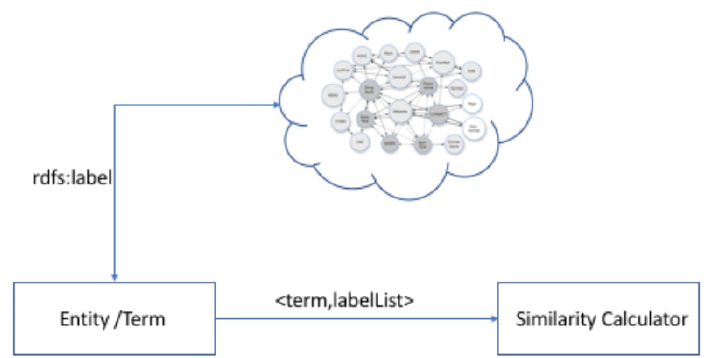
Figure 8. Entities enrichment process usingLinked Open Data (LOD) in